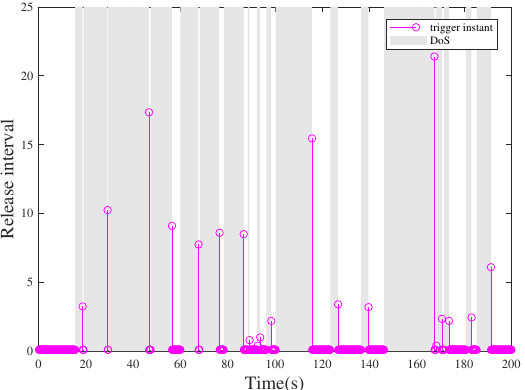
Figure 10. Period of triggering control systems under aperiodic DoS